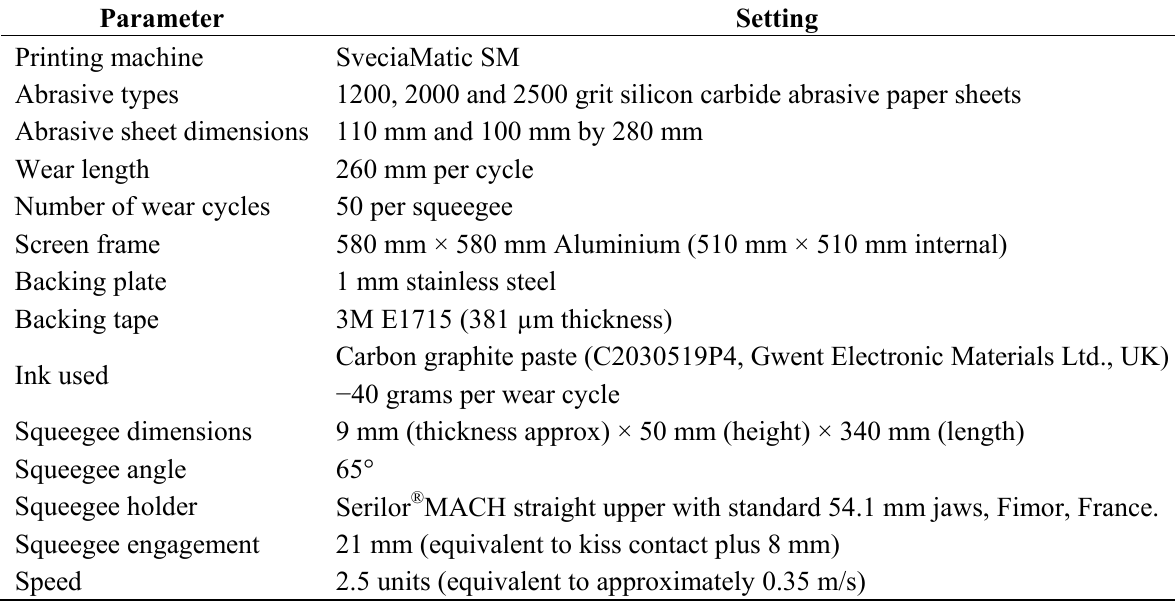
Table 2. Parameters used in wear